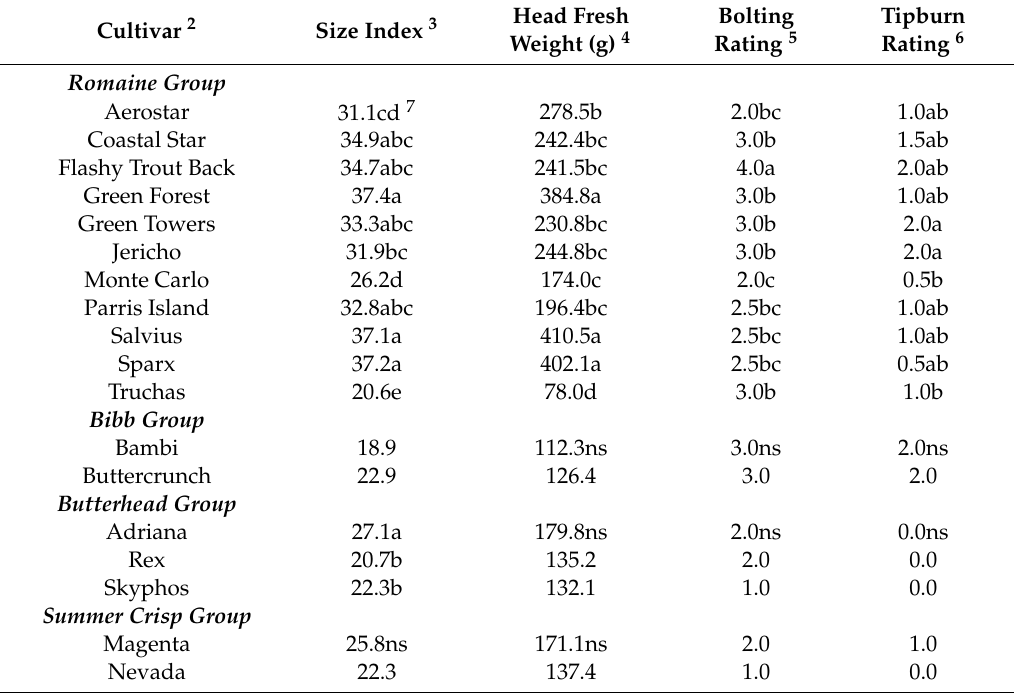
Table 3. Di ff erences in size index, head fresh weight, bolting rating, and tipburn rating among cultivars of four lettuce types 1 grown in deep water culture in a greenhouse for a 30-d